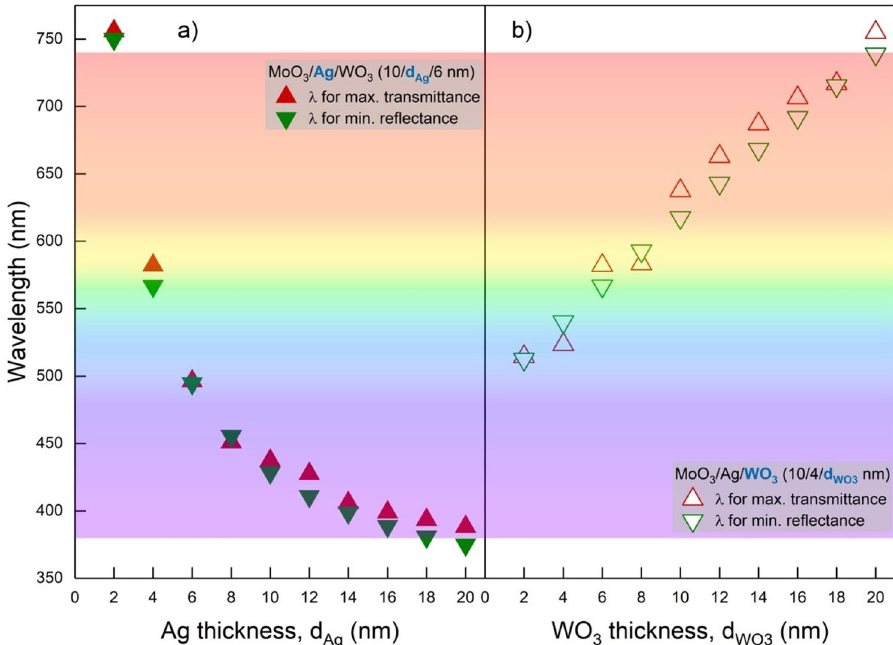
Figure 4. Maximum transmittance and reflectance values of the transparent contact structure. Wavelength changes of minimum reflectance and maximum transmittance corresponding to ( a ) d Ag and ( b ) d WO 3 values in MoO 3 /Ag/WO 3 (10/ d Ag / d WO 3 nm) transparent contact structure. Particularly, structures with minimum reflection at wavelengths close to 550 nm can be used as antireflection in various optoelectronic devices. It can be designed that a transparent or an anti-reflection contact system is optimized for lower wavelengths with d Ag and for larger wavelengths with d WO 3 .